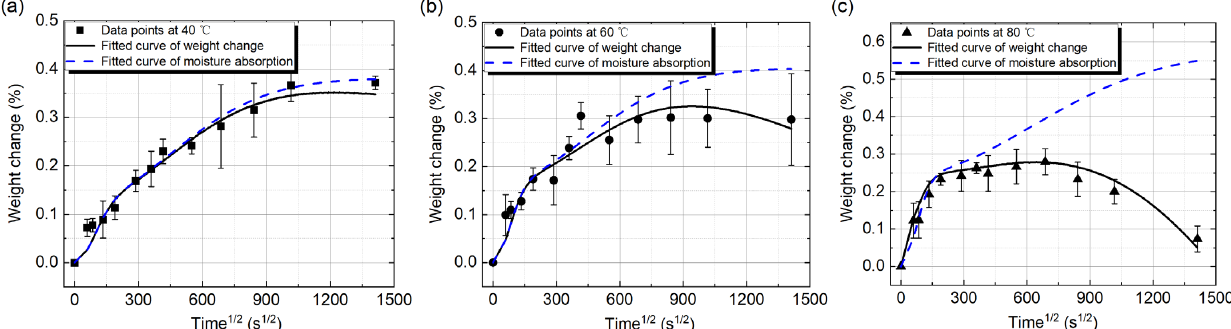
Figure 6. Weight changes of the samples fitted by the modified Langmuir model. ( a ) 40 °C; ( b ) 60 °C; ( c ) 80 °C.